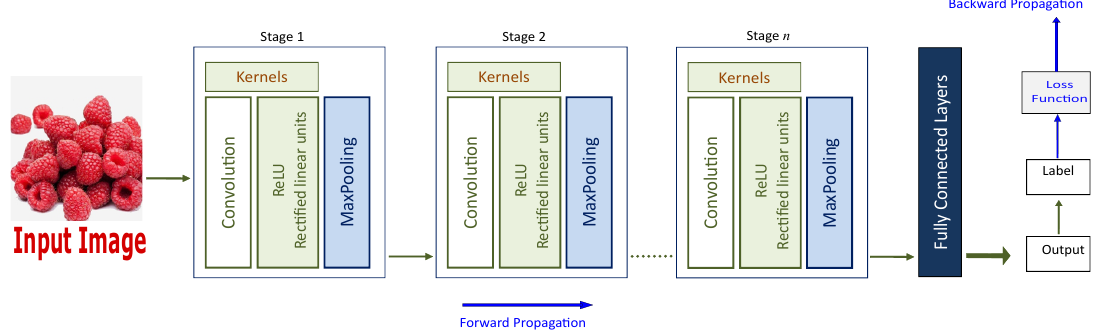
Figure 3. General architecture of a convolutional neural